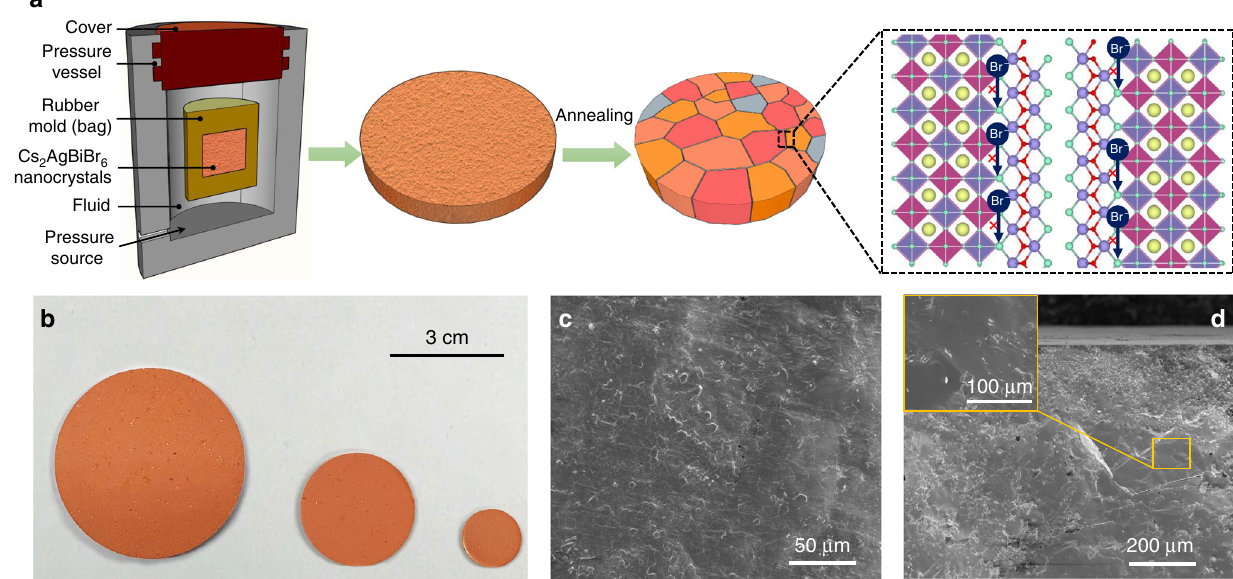
Fig. 1 Isostatic-pressing method to prepare Cs 2 AgBiBr 6 wafers. a Schematic illustration of the isostatic-pressing process, while Cs 2 AgBiBr 6 powders were fi rstly modeled into a pie shape and then subsequently subjected to a pressure of 200 MPa through a hydraulic press, and the additional annealing process could enhance the crystallinity and grain growth. b As-prepared Cs 2 AgBiBr 6 wafers with tunable sizes and the diameters are 5, 3, and 1 cm from left to right. c Top – down scanning electron microscopy (SEM) of the wafer. d Cross-sectional SEM image of the wafer and the inset is a higher resolution image, demonstrating the grain size is larger than 100 μ